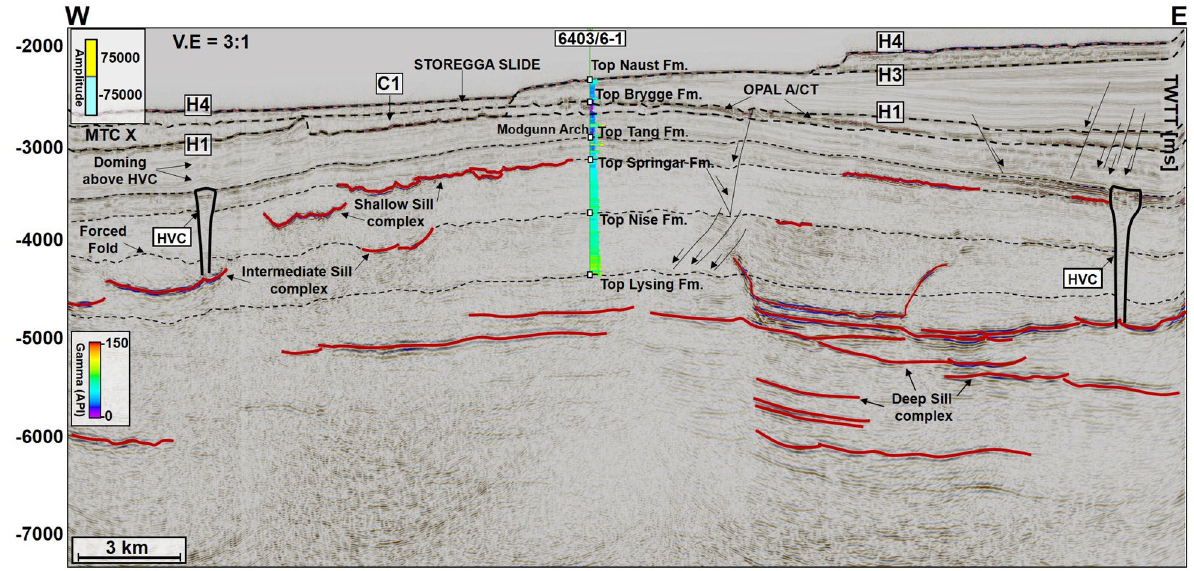
Figure 2. W–E seismic reflection profile showing the stratigraphic framework of the MC3D-MGS2002-FULL- OFFSET_3D_FM_TVFGC (SMA) seismic volume. The surface of interest is horizon H1, which corresponds to the Top Brygge Formation in well 6403/6-1. The strata underlying the study interval are often intruded by magmatic sills. In addition, hydrothermal vent complexes are also interpreted in the proximity of some of the magmatic sills. N.B: The uninterpreted seismic profile is provided in the